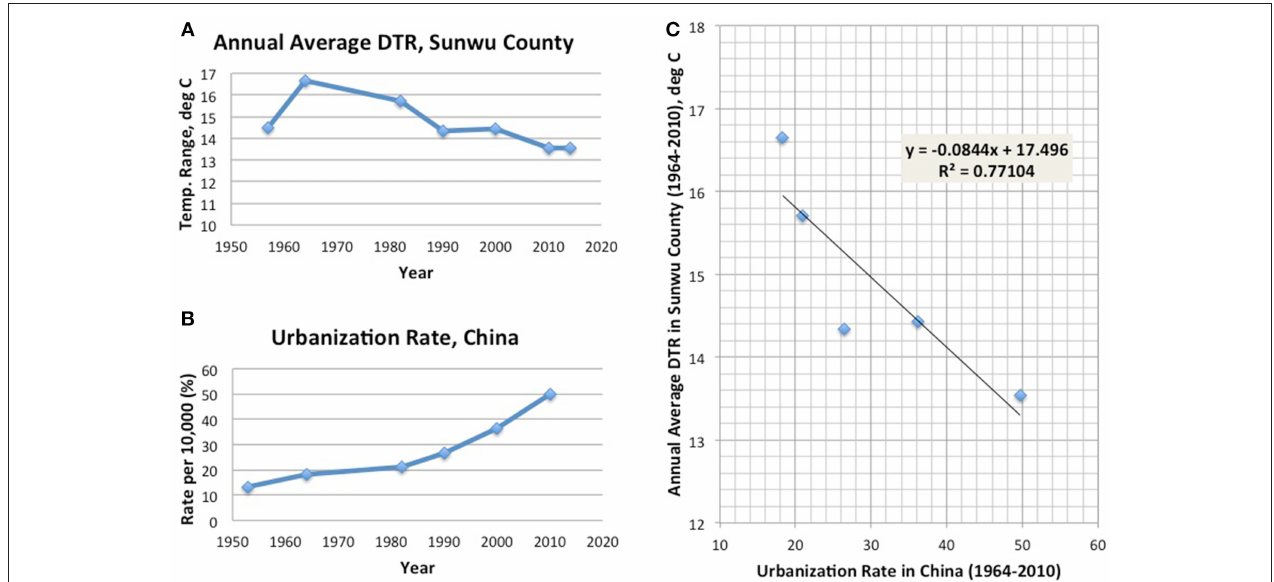
FIGURE 1 | Relationship between DTR and urbanization. (A) Annual average diurnal temperature ranges in Sunwu County for the years 1957, 1964, 1982, 1990, 2000, 2010, and 2014, from TuTiempo S.L. (http://en.tutiempo.net/climate/05-1964/ws-505640.html); (B) Urbanization rate in China from the China Statistical Yearbook 2013 for the years 1953, 1964, 1982, 1990, 2000, and 2010 (http://www.stats.gov.cn/tjsj/ndsj/2013/indexeh.htm); (C) Scatterplot showing the inverse relationship between annual average DTR and urbanization rate on corresponding years, with square of the Pearson R equal to 0.77, as indicated below the trendline